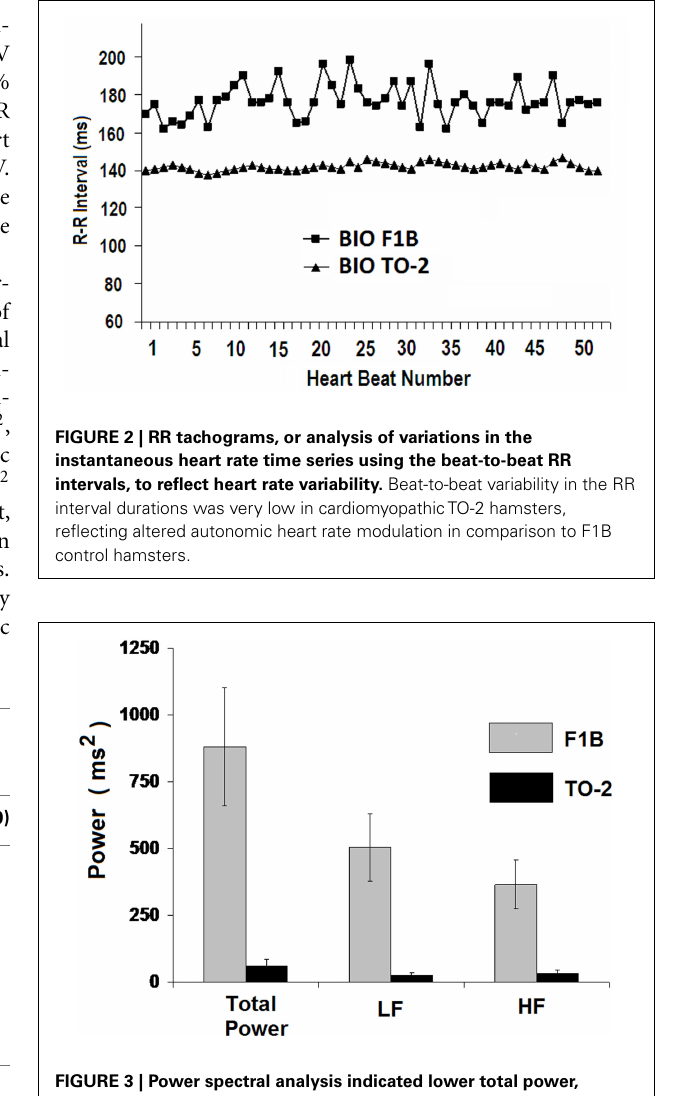
FIGURE 3 | Power spectral analysis indicated lower total power, comprised of reduced LF (sympathetic influences) and reduced